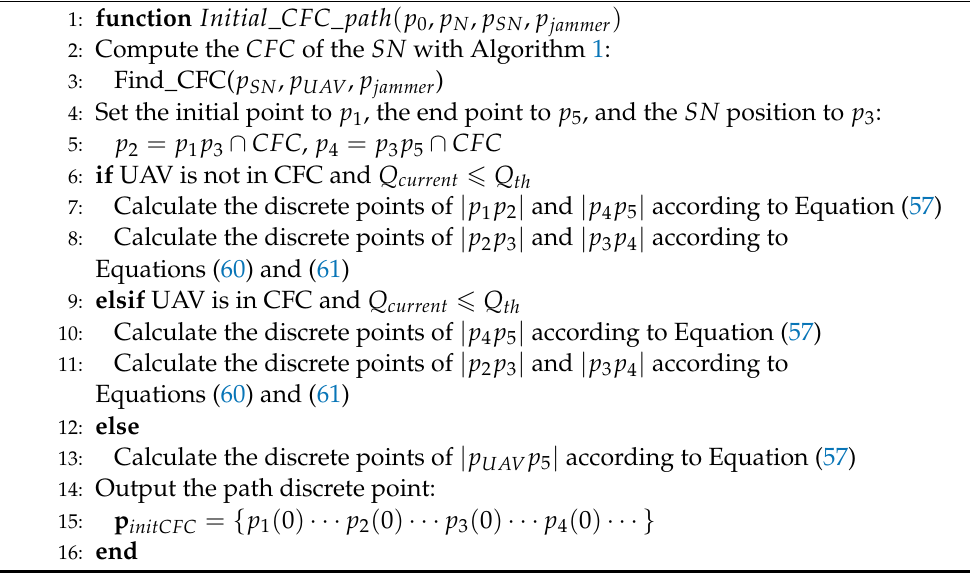
Algorithm 2: For a given initial position p 0 , end position p N , and position of the jammer and SN, find the initial global discrete